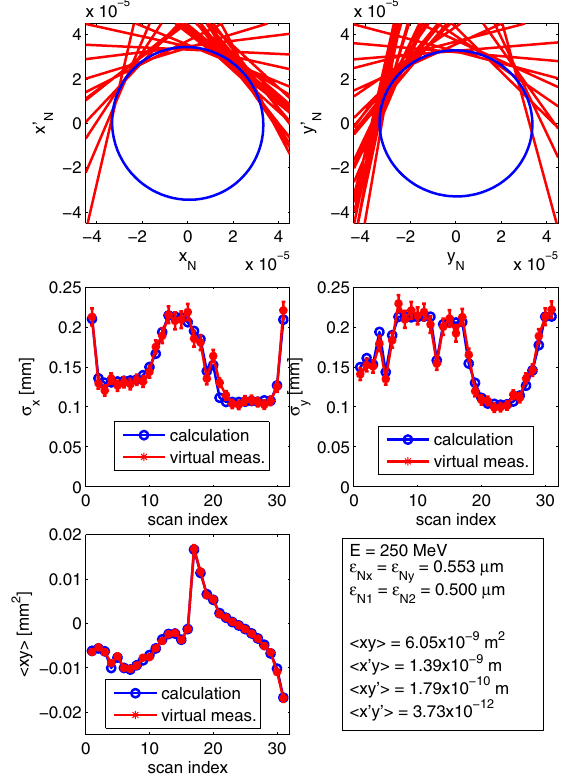
FIG. 4. Simulated measurement example. The nominal beam parameters are indicated in the box. Upper plots show the normalized phase space at the reconstruction point for x (left) and y (right) — the blue circles are the calculated normalized ellipses and the red lines correspond to the beam size measure- ments transported from the measurement location to the reconstruction point. (The variables u and u 0 are normalized to ffiffiffiffiffi ffiffiffiffiffi p p β β the measured values: u N ¼ u= , u 0 N ¼ ð u α u þ u 0 β u Þ = . In u u this way the reconstructed ellipses are always circles.) Middle and lower plots show the computed and virtually measured beam sizes and x - y correlations at the measurement location as a function of the scan index. The computed beam sizes are obtained by transporting the calculated beam parameters at the recon- struction point to the measurement location. See also Fig.